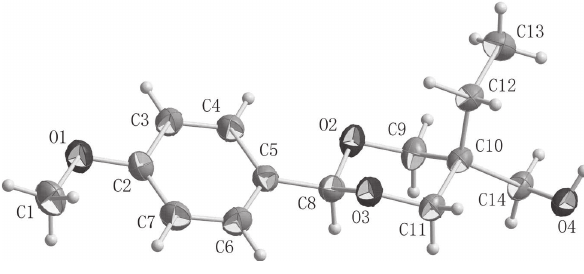
Table 1: Data collection and handling.